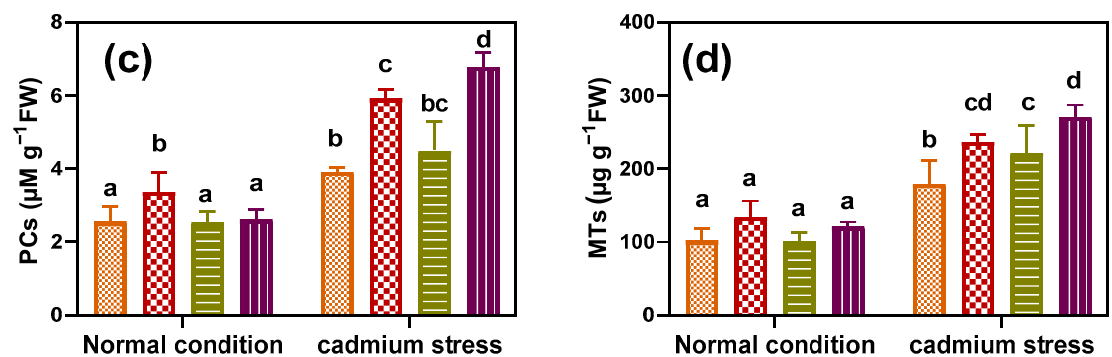
Figure 3. ( a ) Activity of glutathione S-transferase (GST, µ mol GSH-CDNB conj. mg − 1 (protein) min − 1 ), ( b ) reduced glutathione (GSH), ( c ) phytochelatins (PCs) and ( d ) metallothioneins (MTs) in leaves of geranium non-inoculated (NI) or inoculated with different endophytic fungi; T . versatilis (E6651), E . nidulans (E6658) and A . niger (E6657) under normal conditions and Cd-stress; after 17 days of applying stress. Values are expressed as means ± SE ( n = 3–4). For comparison among different treatments within and between levels of both normal conditions and cadmium stress, values with at least one similar letter are non significantly different according to One-way ANOVA with Post Hoc-Tukey HSD test ( p ≤ 0.05).